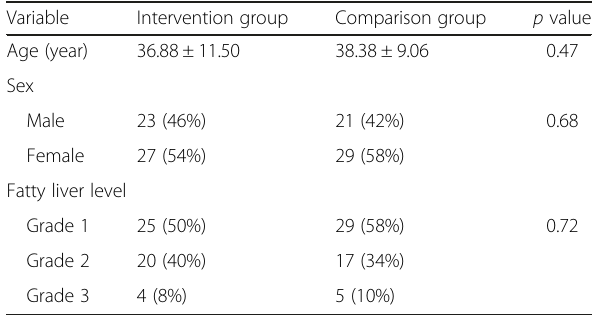
Table 1 Baseline characteristics of participants in two treatment groups